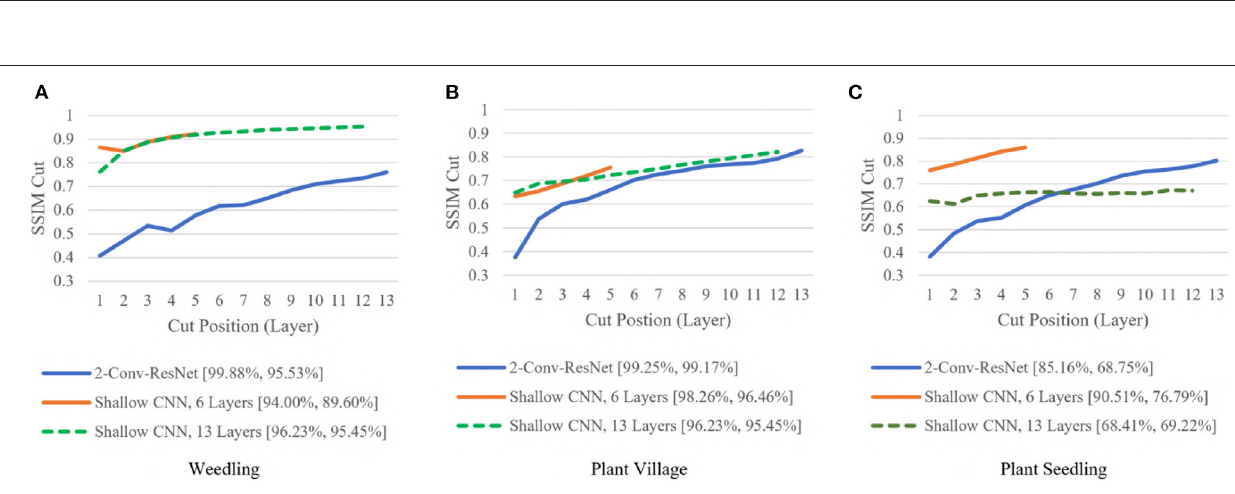
FIGURE 6 | Comparison of the Cut Position (Layer) VS SSIM cut curve for the 2-Conv-ResNet, Shallow CNN, 6 Layers, and Shallow CNN, 13 Layers for different datasets. The value in the legend of the chart indicate the training and testing accuracy of the model. (A) Weedling. (B) Plant village. (C) Plant seedling.